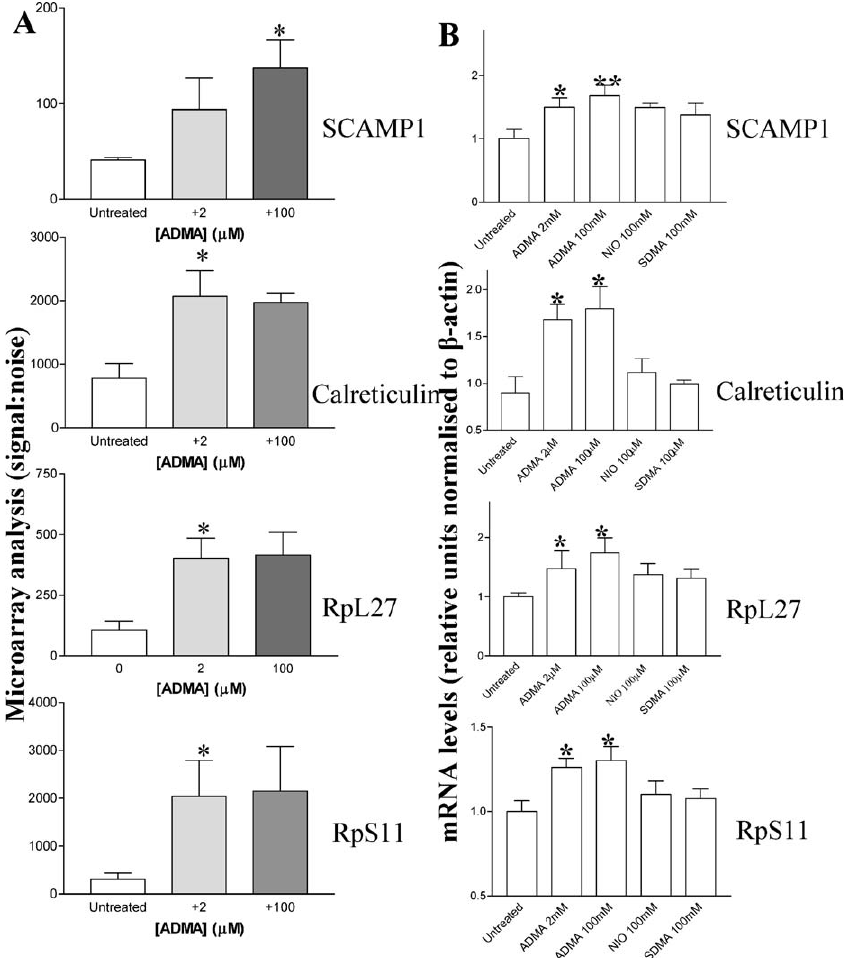
Figure 3. Confirmation of Gene Expression Changed by GeneChip Analysis (A) SCAMP1; Calreticulin, ribosomal protein L-27 (RpL27), and RpS11 signal-to-noise ratios derived from U133A GeneChip analysis where n ¼ 3 (untreated versus 100 l M: SCAMP1 changed 3.16-fold, p ¼ 0.031; and untreated versus 2 l M: Calreticulin changed 2.96-fold, p ¼ 0.047; RpS11, 8.065-fold, p ¼ 0.033; RpL27, 4.39-fold, p ¼ 0.048). (B) SCAMP1; Calreticulin, RpL27 , and RpS11 mRNA levels are elevated by ADMA (2 and 100 l M; * p , 0.05 and ** p , 0.01). SDMA (100 l M) and L-NIO (100 l M) did not elicit changes in gene expression as shown by Northern blotting, where mRNA was corrected for differences in b -actin mRNA expression. DOI: